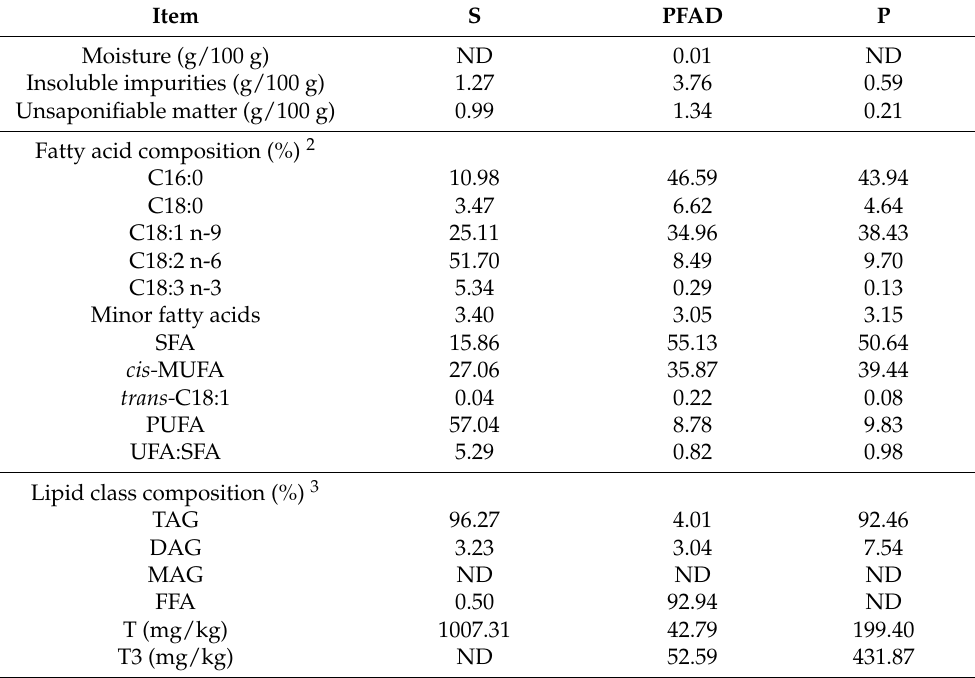
Table 2. Chemical analyses of the experimental fats 1 .